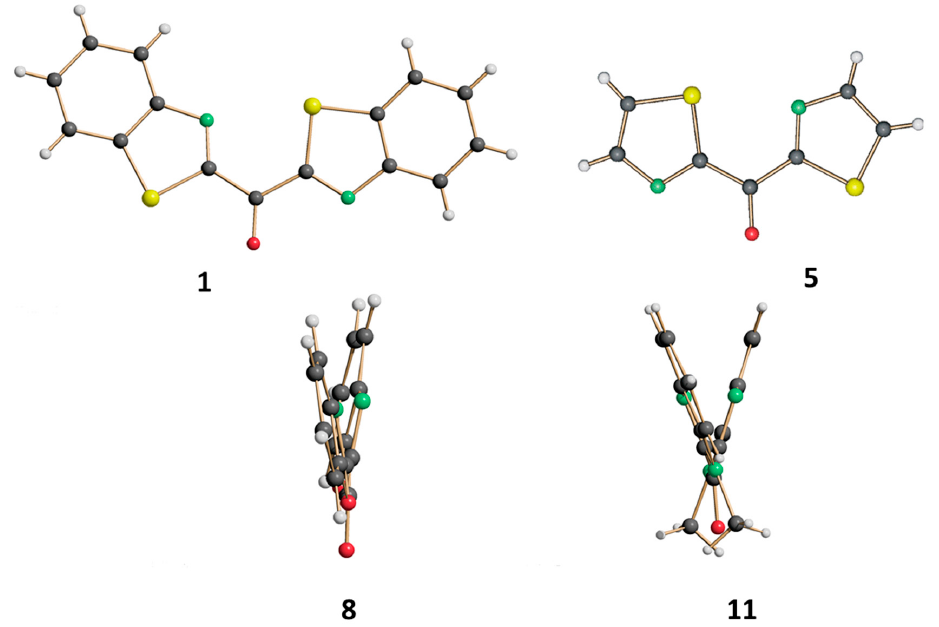
Figure 1. Molecular structures of compounds 1 , 5 (front-view), 8 , 11 (side-view) determined by X-ray studies.